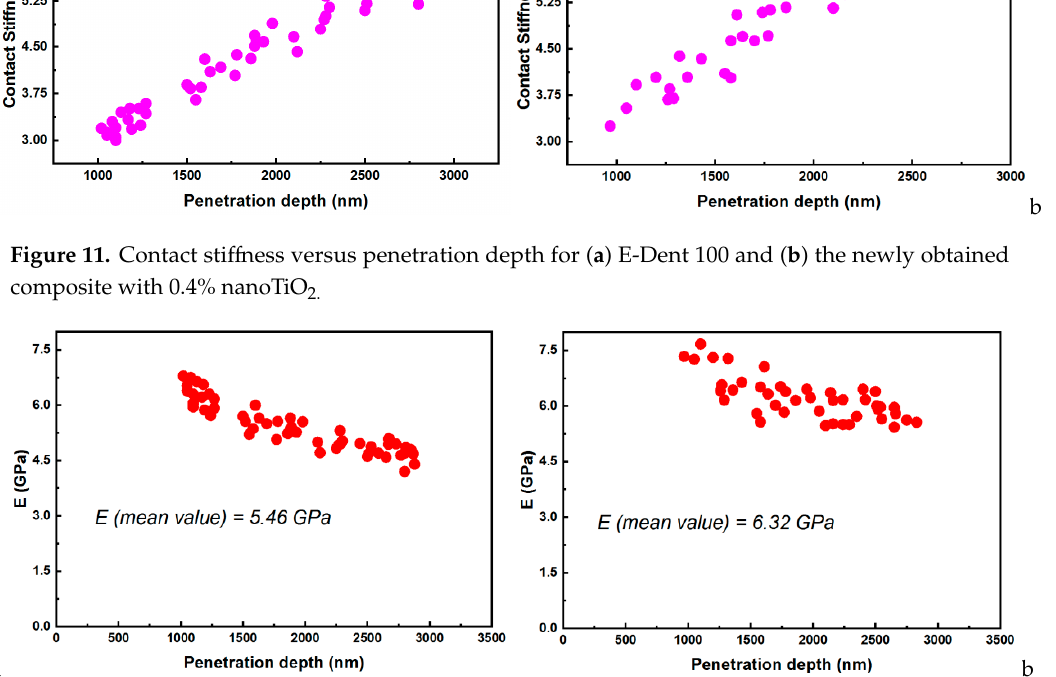
Figure 12. Elastic modulus versus penetration depth for ( a ) E-Dent 100 and ( b ) the newly obtained composite with 0.4% nanoTiO 2